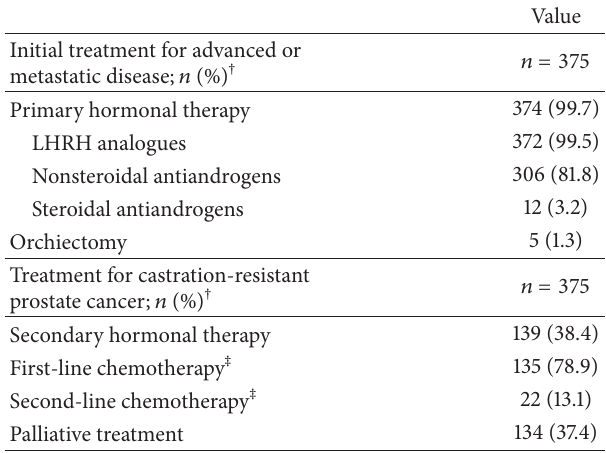
Table 2: Treatment decisions for management of advanced prostate cancer.